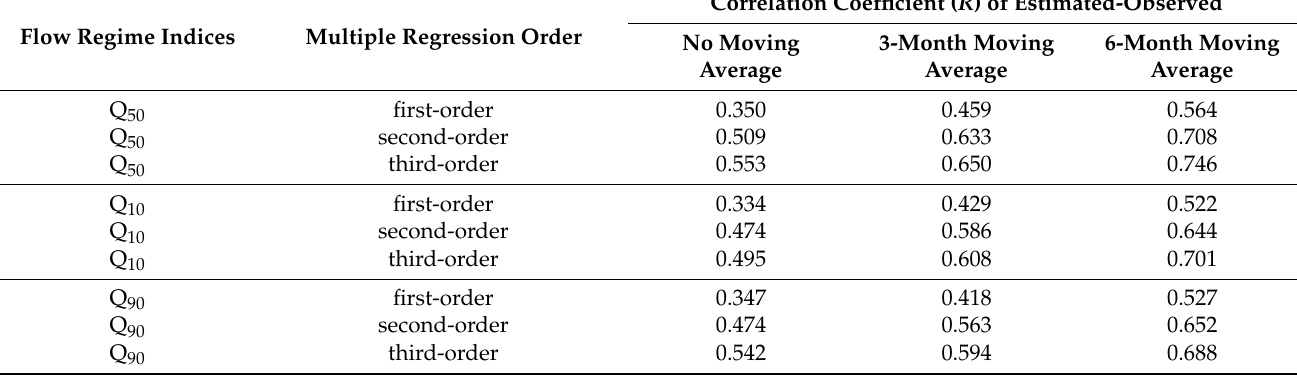
Table 2. The Pearson correlation coefficient ( R ) between the estimated and observed values of streamflow regimes on second- and third-order multiple polynomial regressions with SOI and DMI as